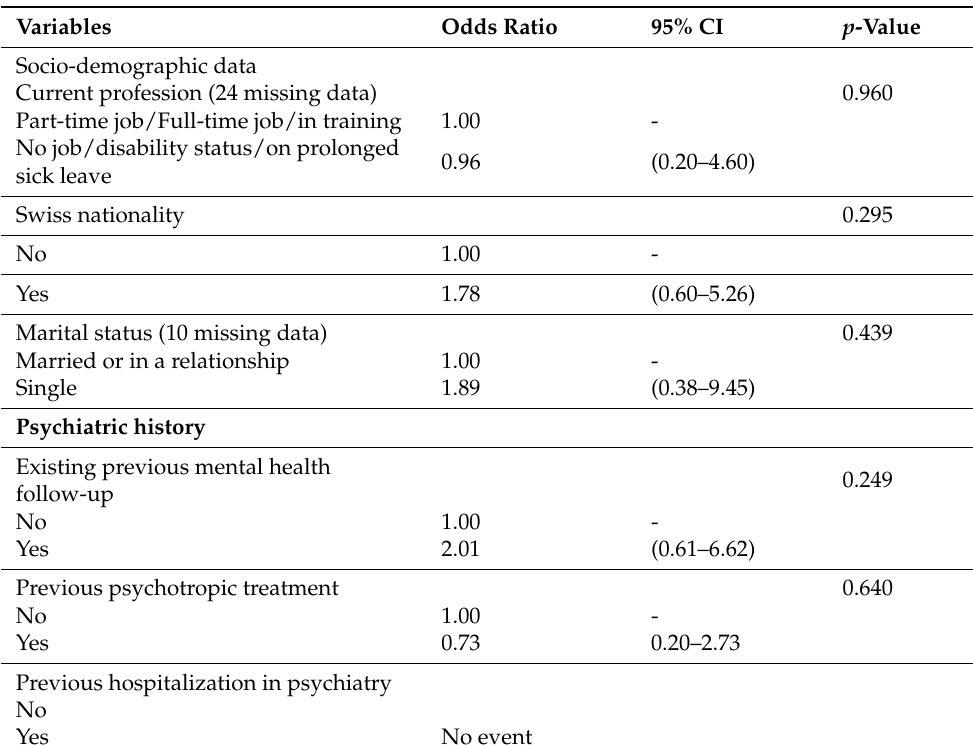
Table 9. Variables associated with a birth-related PTSD diagnosis according to DSM-5 at one month post-partum (measures of associations, univariate